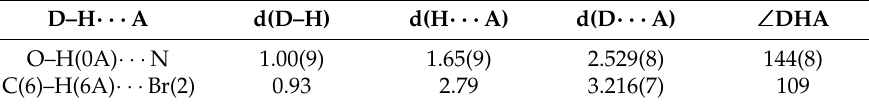
Table 3. Hydrogen bond lengths (Å) and bond angles ( ◦